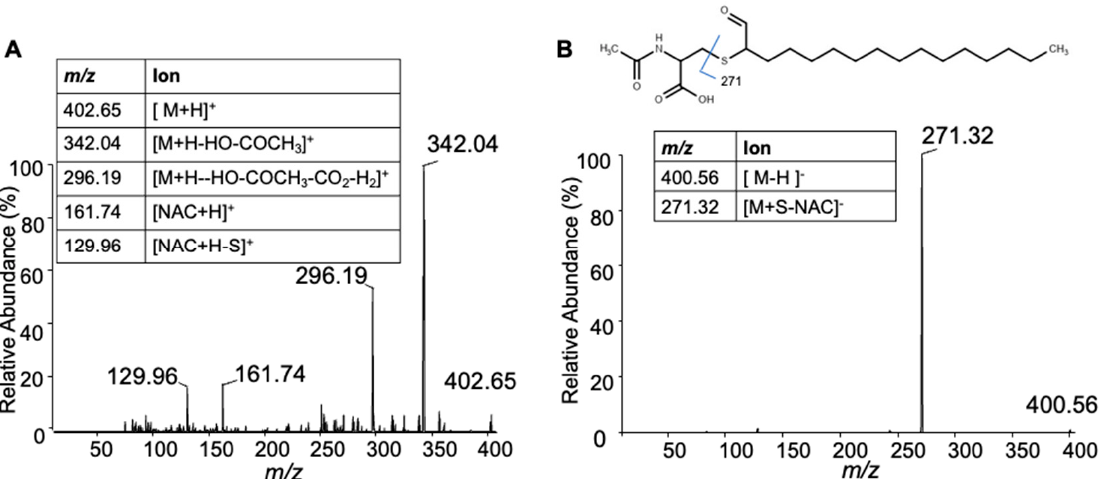
Figure 7. ESI/MS/MS of HDA-NAC. MS/MS spectra for the [M + H] + parent ion at m / z 402.65 ( A ) and the [ − M − H] − parent ion at m / z 400.56 ( B ) are shown. Inset tables provide fragment ion assignments.